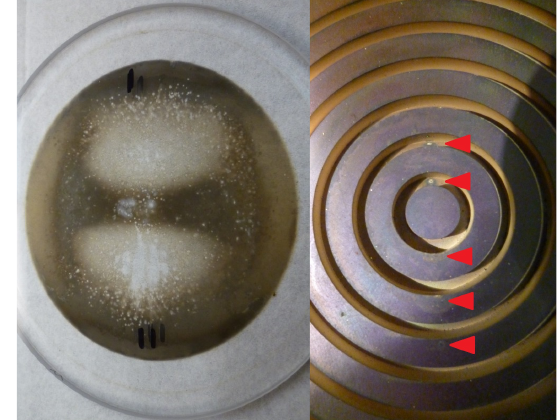
Fig 5. Fused silica window (left) from 12cm porthole antenna with sputtering from arcing in the vacuum side of the pillbox window. Grooved boron nitride limiter cover (right) used on 12cm porthole antenna. Cover shows signs of arcing (red triangle) parallel to the RF electric field near the center. RF electric field is oriented vertically in this